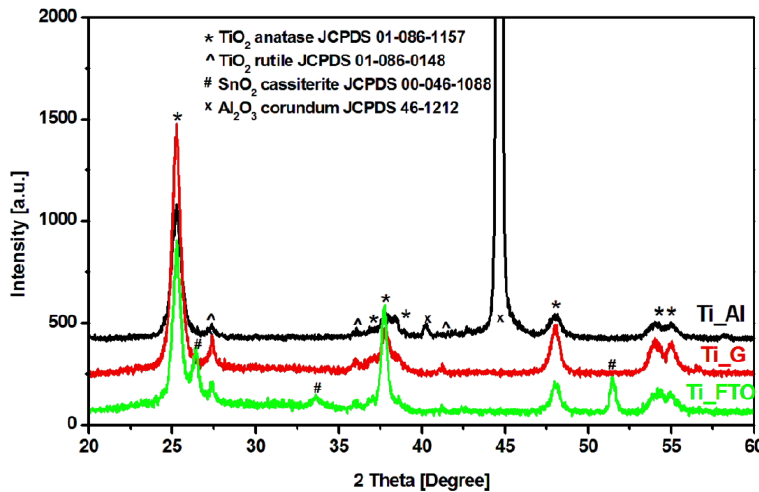
Figure 1. X-Ray diffraction pattern corresponding to Ti_Al (TiO 2 film on an aluminum substrate), Ti_G (TiO 2 film on a microscopic glass substrate), and Ti_FTO (TiO 2 film on a flour-doped tin oxide substrate) samples.